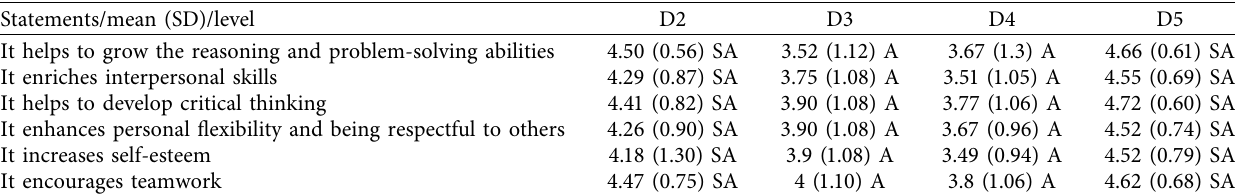
Table 2: Mean, standard deviation, and level of statements of the second parameter (interpersonal skills improvement) according to the Likert scoring method where SA is referred to strong agree and A is referred to agree.